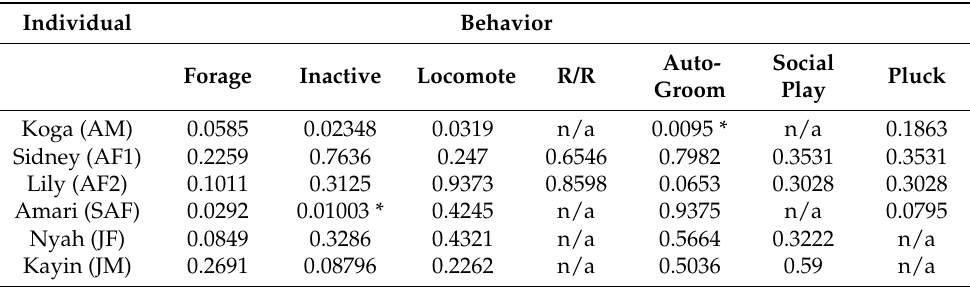
Table 3. p values for Mann–Whitney U tests for each behavior and individual gorilla. p values adjusted for multiple comparisons (alpha = 0.01). Significant behaviors are noted with *.